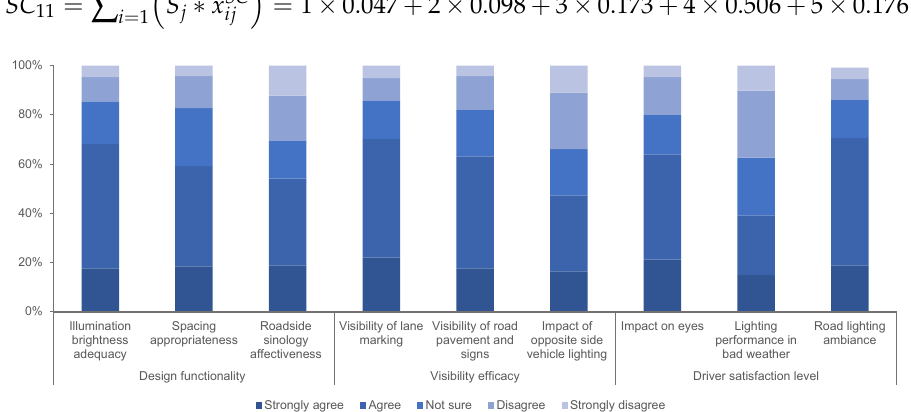
Figure 5. Stacked columns summarizing the percentages for all response levels obtained for each sub-criterion.